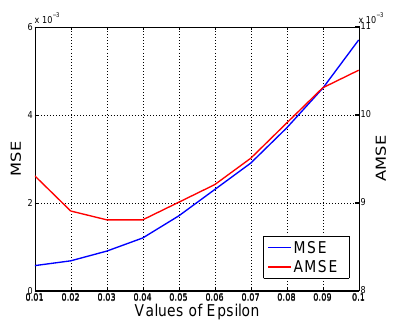
k sub-points set which has 300 / k points. Each set is separately used as testing points and the rest is training points set. k = 30 in our experiments. With one parameter point ( s , e , C ) , the regression func- tion would be trained 30 times, and there are 30 MSE values of testing points. The average of these MSE value is named AMSE.